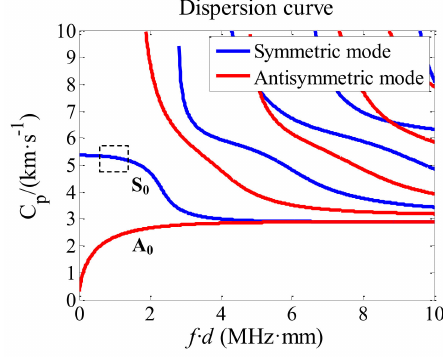
Figure 1. Dispersion curves of Lamb waves in a free aluminum